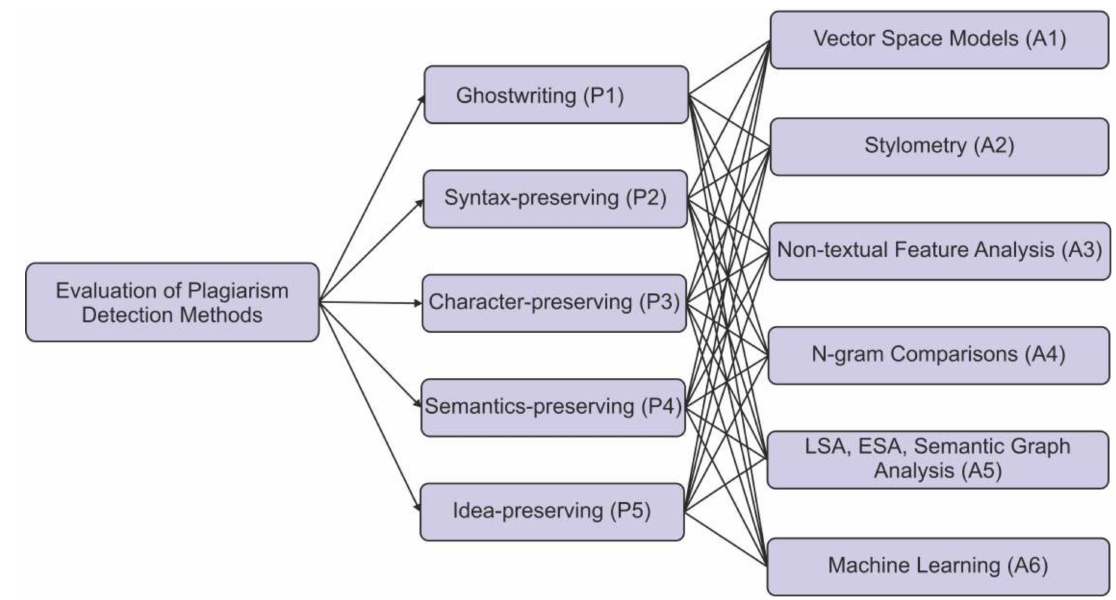
Figure 1. Hierarchy for the evaluation of different plagiarism-detection